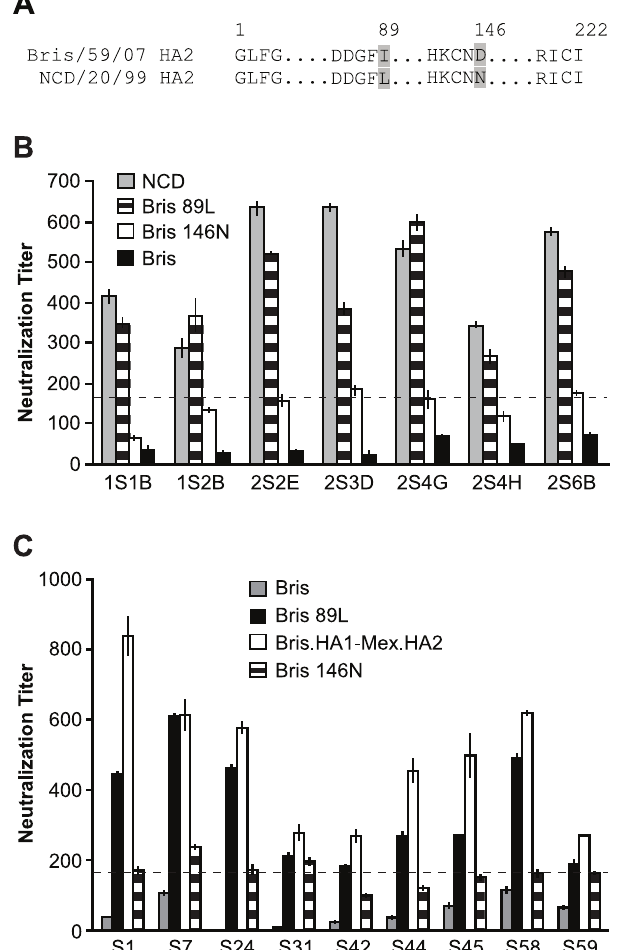
Figure 6. The amino acid at position 89 in HA2 influences neutralization to HA2. (A) Sequence comparison of HA2 from Bris/59/07 and NCD/20/99. The differing residues in the HA2 are indicated (grey). (B) The 89L mutation, but not the 146N mutation in HA2 of Bris/59/07, conferred similar levels of neutralization to Bris/59/07 HA-pseudotypes as compared to NCD/20/99 HA-pseudotypes, using sera from the NJ/76 vaccine trials that have neutralization titers to NCD/20/99, but not to wild-type Bris/59/07. (C) The 89L mutation, but not the 146N mutation in Bris/59/07 HA2, conferred similar levels of neutralization to Bris/59/07 HA-pseudotypes as compared to chimeric HA-pseudotypes with Mex/4108/09 HA2, using the contemporary sera cohort from samples that have neutralization titers to Mex/4108/09 HA2 (determined in Figure 5A), but not to wild type Bris/59/ 07. The dotted lines in both panels B and C represent the neutralization titer of 160, which has been proposed as a correlate of seroprotection in microneutralization assays involving replicating influenza virus [4]. Protective titers for neutralization of HA-pseudotypes have not been determined. Data are shown as means + / 2 SD and reflect two or more independent experiments with each sample run in duplicate. Bris: Bris/59/07; Mex: Mex/ 4108/09; NCD: NCD/20/99.